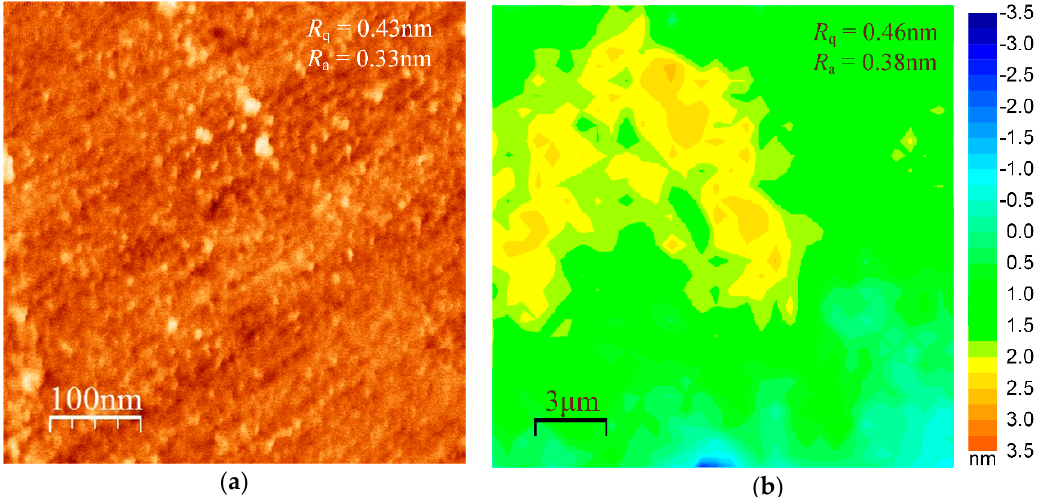
Figure 2. The surface roughness of cross-sectional surface measured by ( a ) atomic-force microscope (AFM) and ( b ) white-light interferometer.